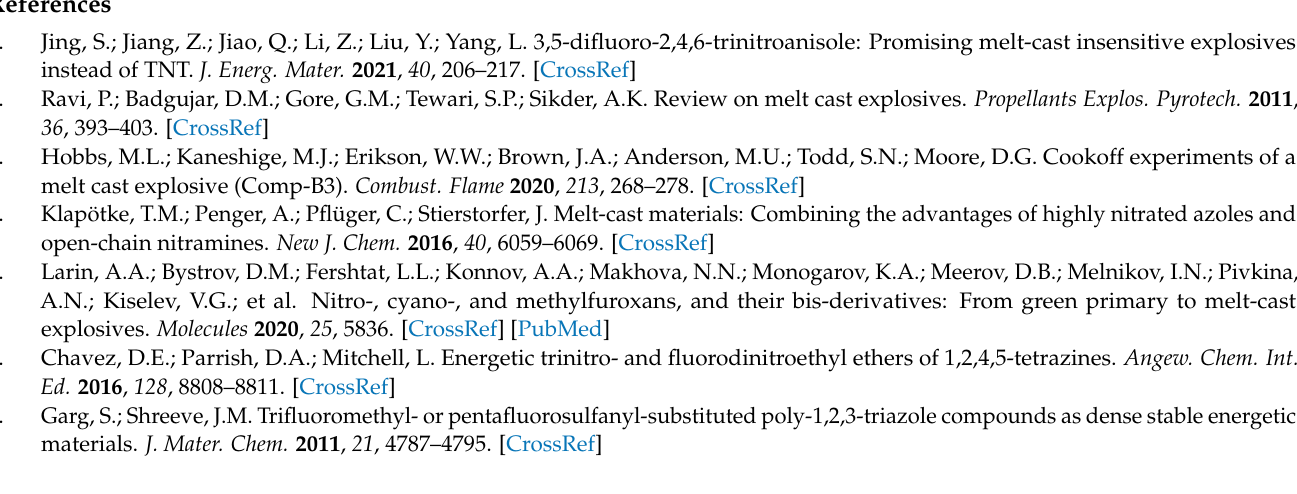
Figure S2: 3D FTIR spectrum of the pyrolysis gaseous products of DFTNAN and TNAN.; Figure S3: MS curves of the pyrolysis gaseous products of DFTNAN; Figure S4: FTIR spectrum of the DFTNAN and TNAN; Figure S5: MS curves of the pyrolysis gaseous products of TNAN. Table S1: The m/z of Py-MS and possible assignments; Table S2: Gaseous products of DFTNAN after T-jump pyrolysis identified by GC-MS (Retention time with corresponding molecular structures); Table S3: Gaseous products of TNAN after T-jump pyrolysis identified by GC-MS (Retention time with corresponding molecular